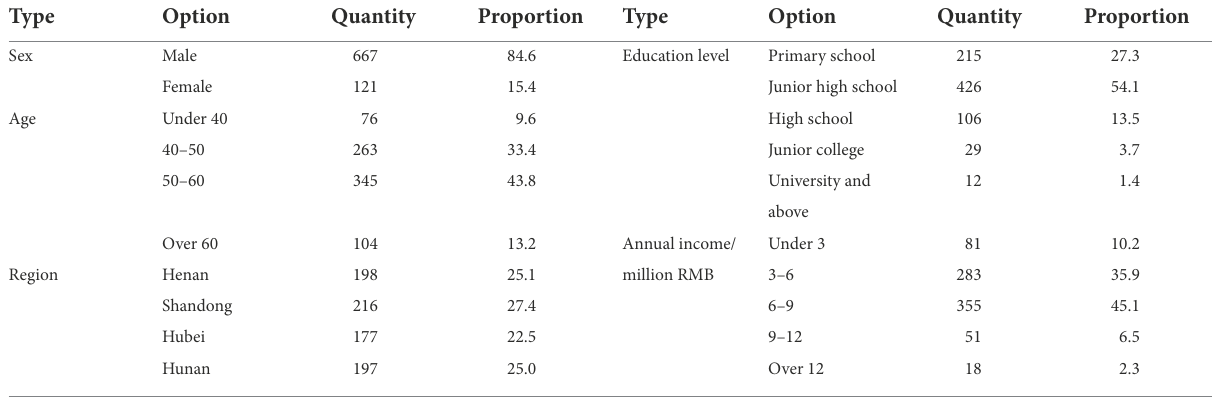
TABLE 1 Main characteristics of the sample and its